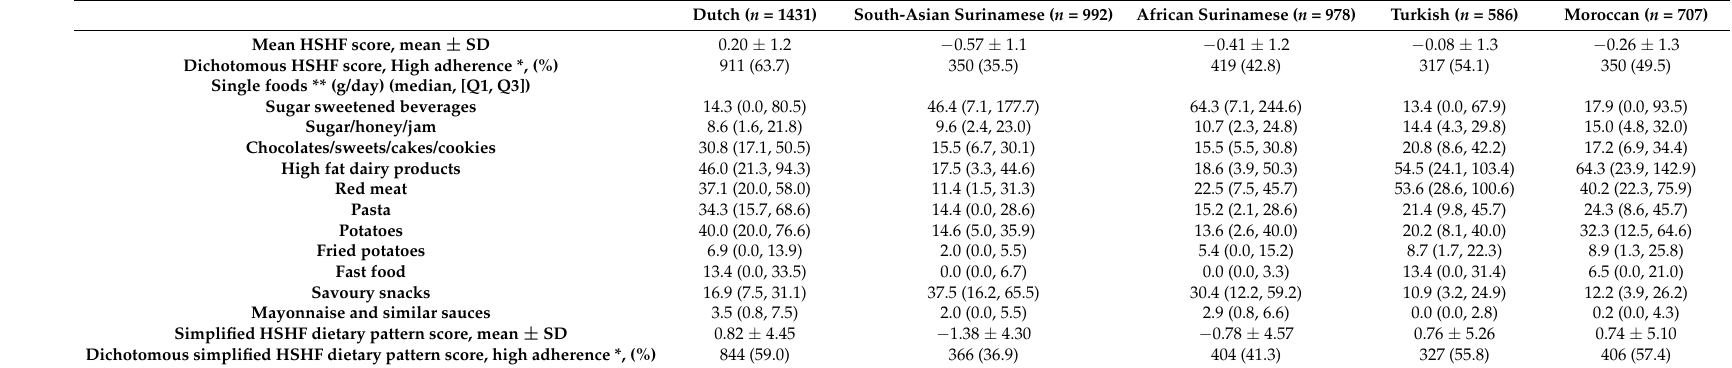
Table 2. HSHF dietary pattern and single foods by ethnicity.